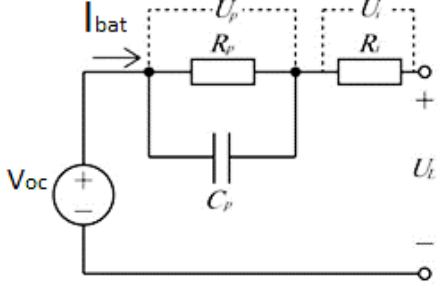
Figure 2. Equivalent circuit model of the battery.